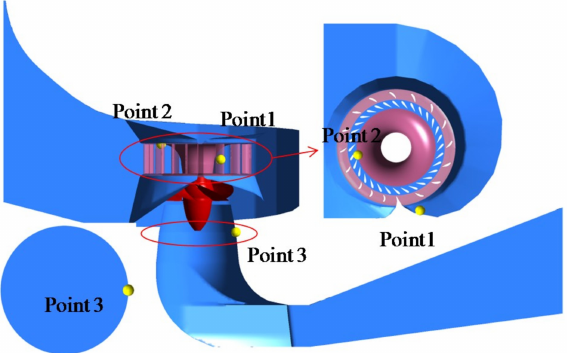
Figure 3. Monitoring points of static pressure in the whole